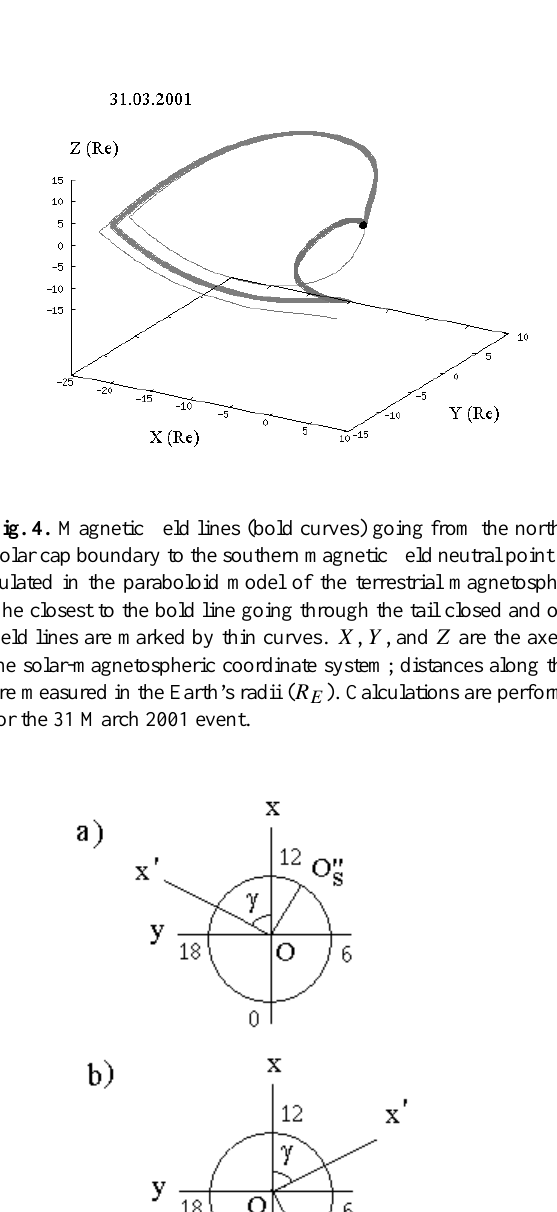
Fig. 5. Projection on the Earth’s equatorial plane of the X perpendicular to the surface ( η ) containing the Region 1 currents deformed by the IMF. The transition current system is magnetic field extrema are located along this line. OO parallel to the projection on the equatorial plane of a line belonging to the surface η and crossing the southern neutral point O projection on this surface of the Earth’s center ( O ). Components of the magnetic field penetrated into the magnetosphere from the solar wind: (a) b x < 0; b y > 0; b z > 0; (b) b x > 0; b y > 0; b z >